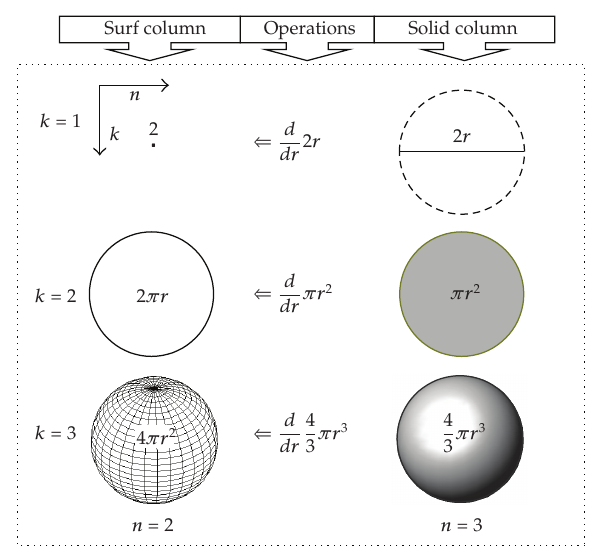
Figure 1: Moving through the vector of real surfaces left: by deducting one degree of freedom k of the surface sphere, we obtain circumference, and for two (cid:2) degrees (cid:3) , we obtain the point 2. Moving through the vector of real solids (cid:2) right column (cid:3) , that is, by deduction of one degree of freedom k from the solid sphere, we obtain a circle (cid:2) disk (cid:3) , and for two (cid:2) degrees (cid:3) , we get a line segment or